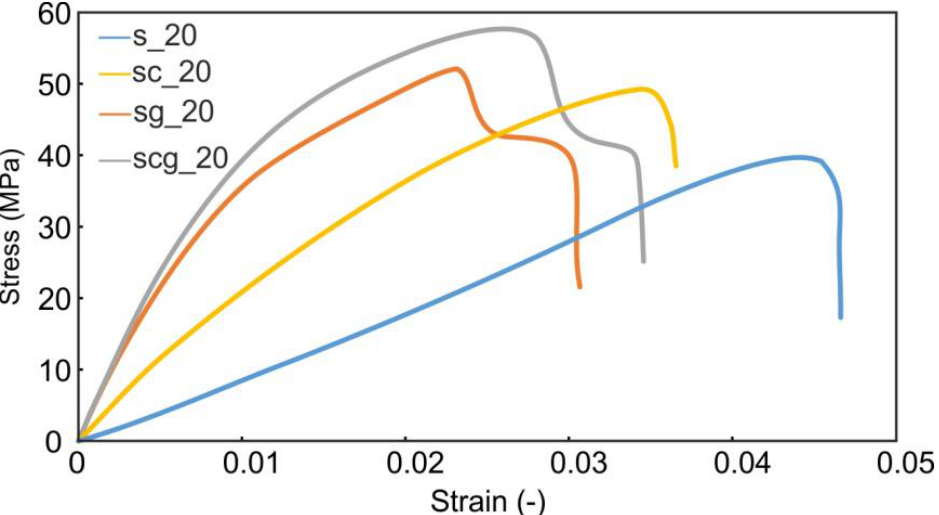
Figure 4. Stress–strain curves of starch films with 20 wt% glycerol, 3 wt% NaMMT and different contents of cellulose and fiberglass fabric.